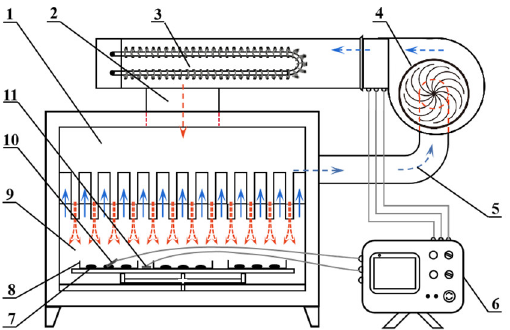
Figure 1. Structure diagram of air impingement drying equipment (The arrows indicate the direction of airflow). (1) Airflow distribution chamber, (2) drying air channel, (3) electric heater, (4) centrifugal fan, (5) drying air recycle channel, (6) temperature sensor of the controller, (7) sample, (8) sample tray, (9) drying chamber, (10) temperature sensor, (11) air velocity sensor.